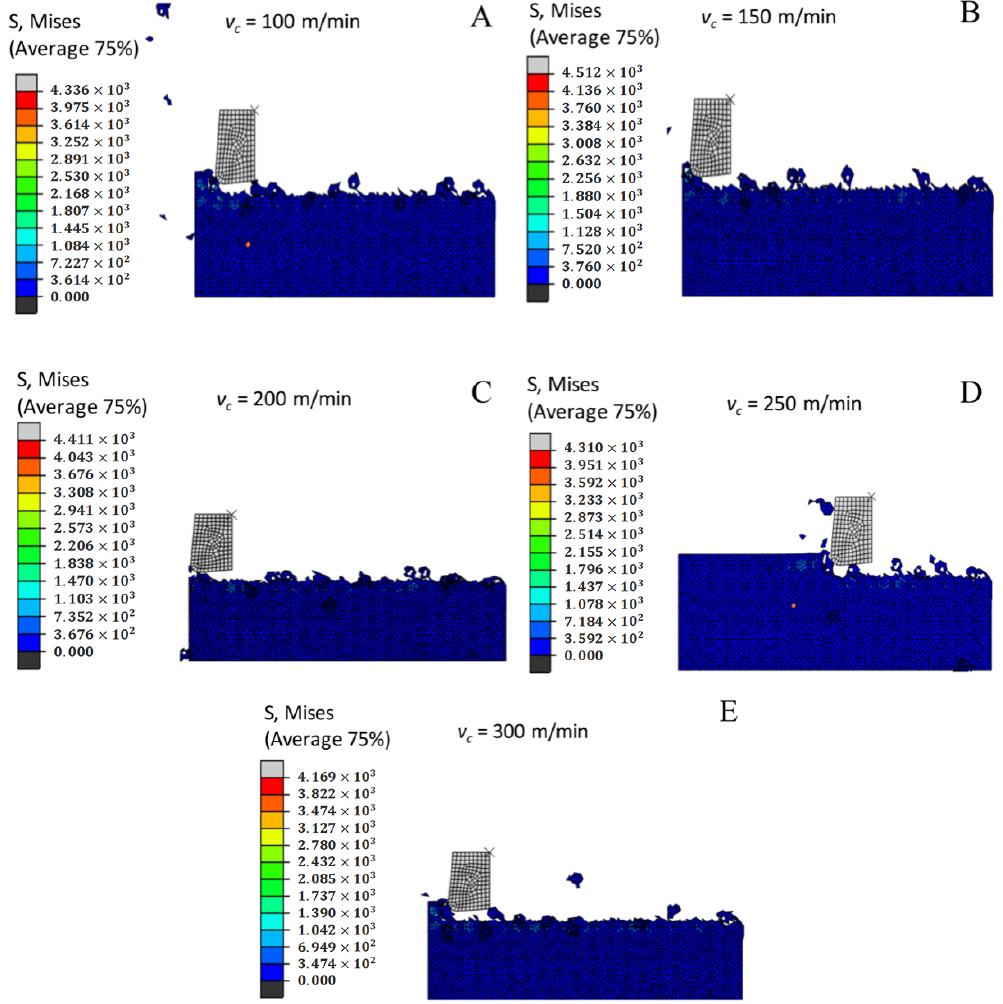
Figure 17. Chip morphology at different milling speeds. ( A ) v c = 100 m/min. ( B ) v c = 150 m/min. ( C ) v c = 200 m/min. ( D ) v c = 250 m/min. ( E ) v c = 300 m/min.